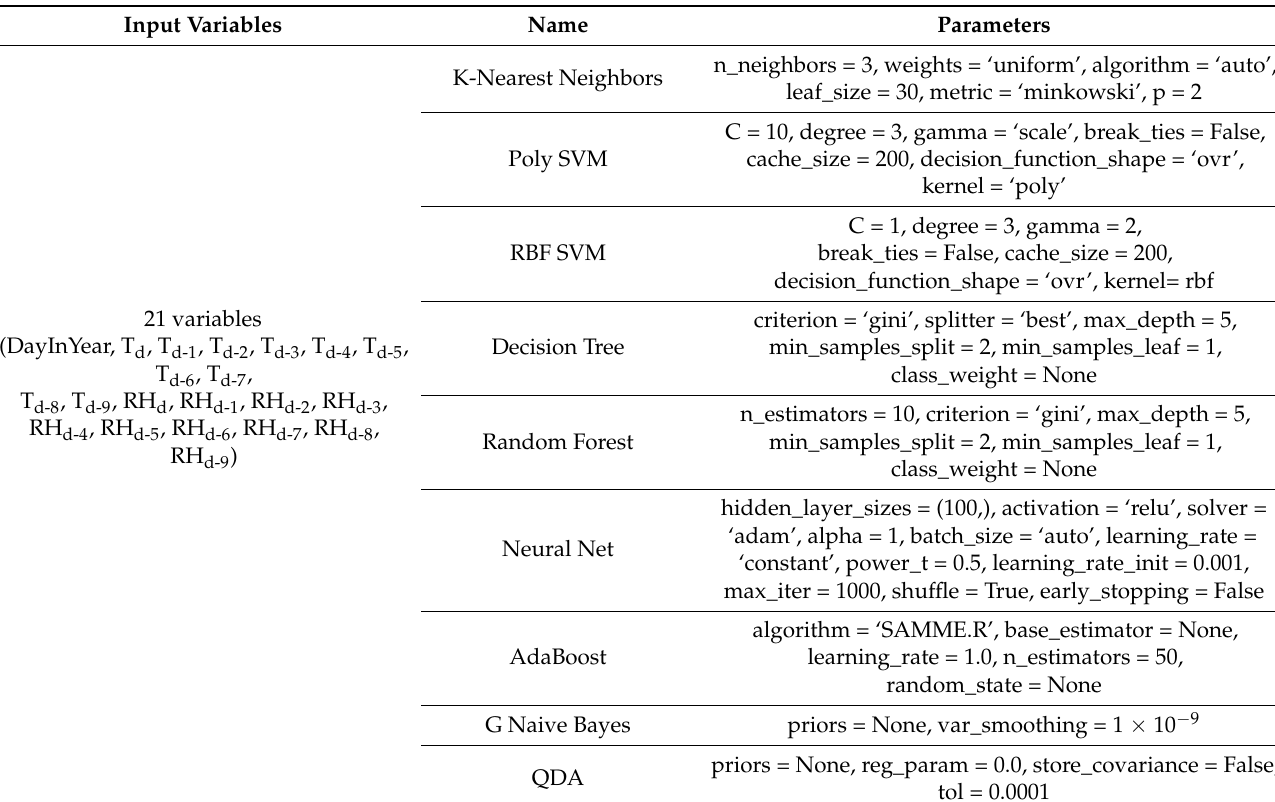
Table 1. Input variables and parameters in used ML models.